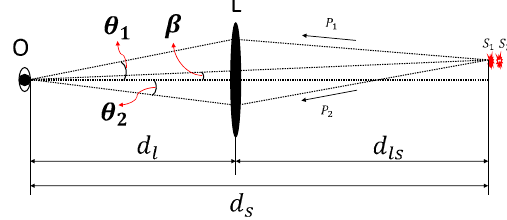
Fig. 1 The geometry of the gravitational lens considered here. Illus- tration of a strongly lensed cosmic transient which can be used to test